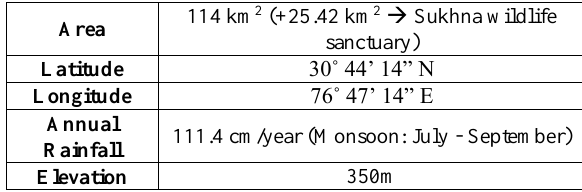
Table 1: Chandigarh: Geographic information